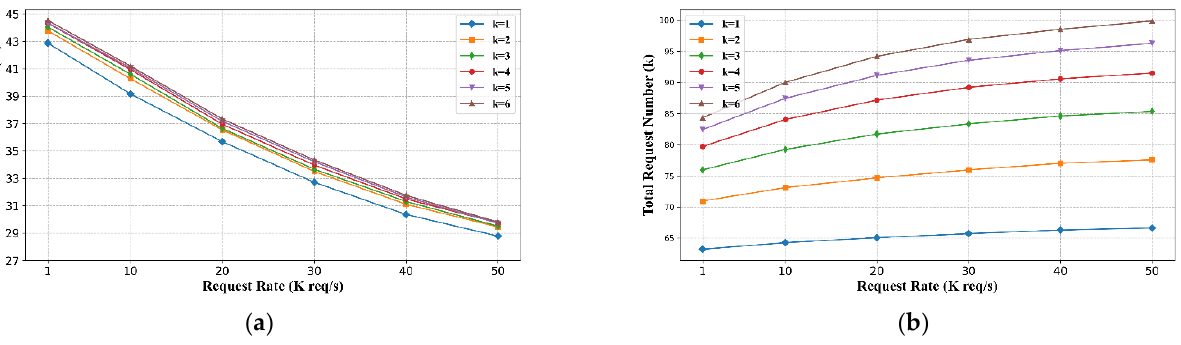
Figure 7. Experiment result of parameter k in ACNR approach. ( a ) Name resolution success rate comparison for each k with different name resolution request rates. ( b ) Total request number comparison for each k with different name resolution request rates.